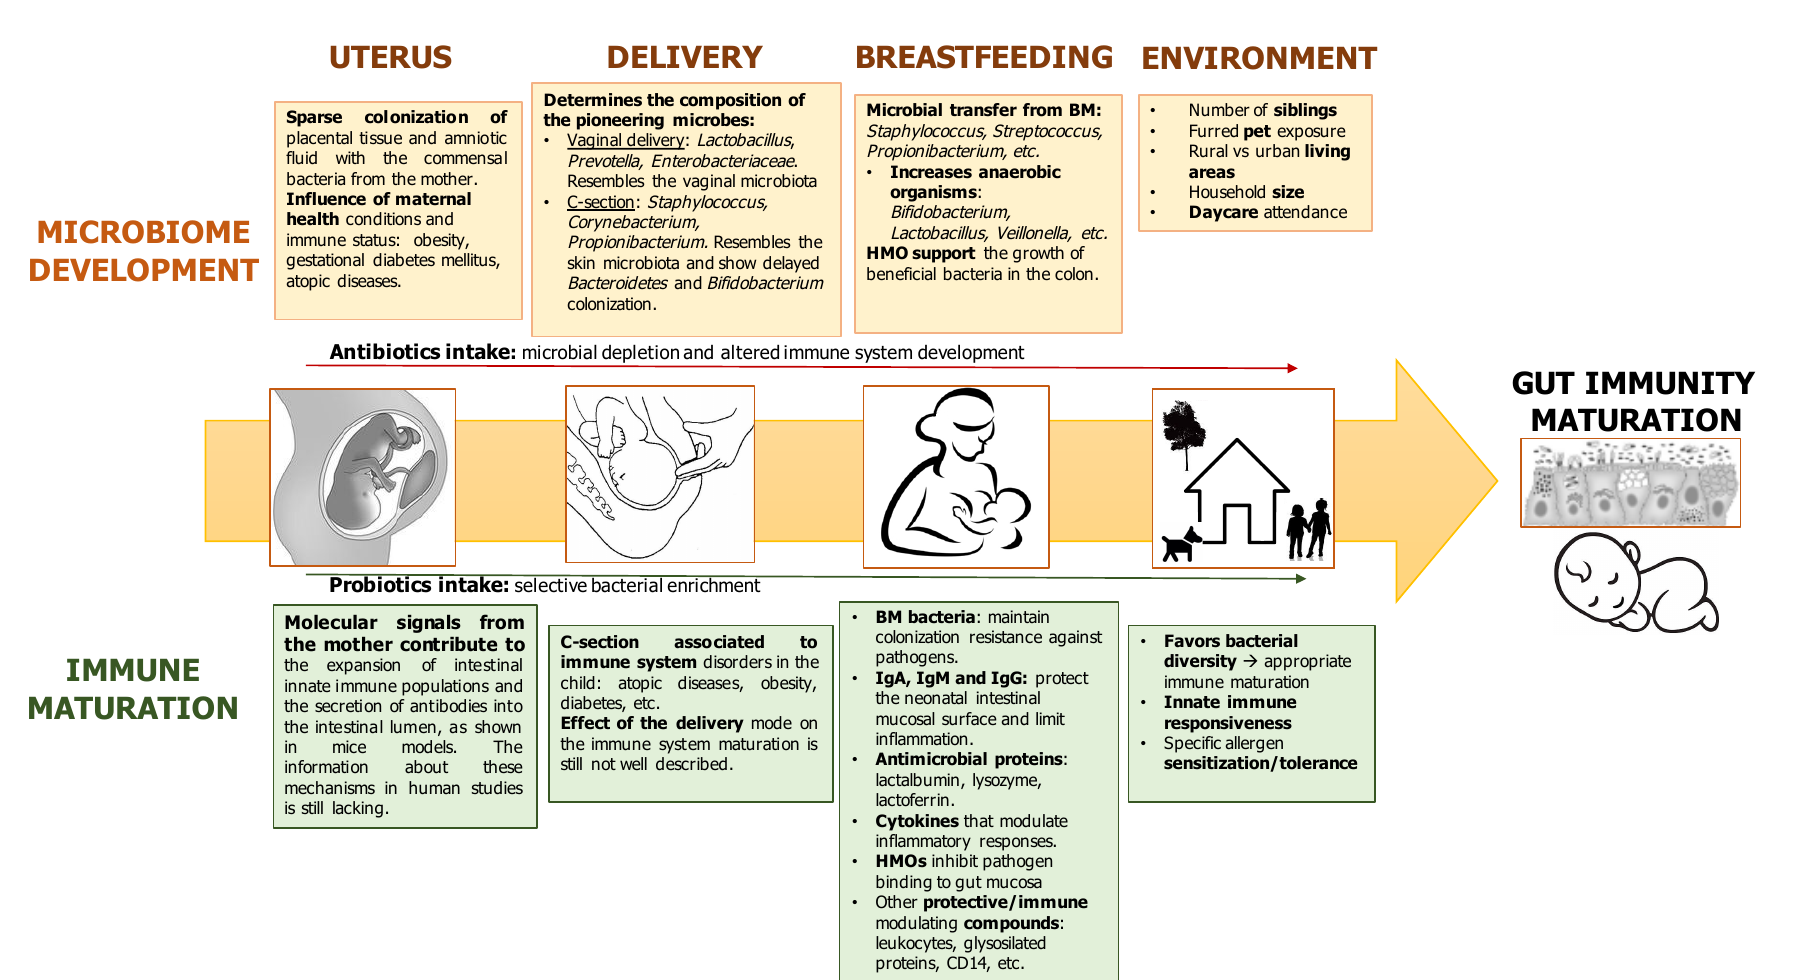
Figure 3. Key factors influencing microbiota development and maturation of the immune system in early life. BM: breast milk; and HMO: human milk